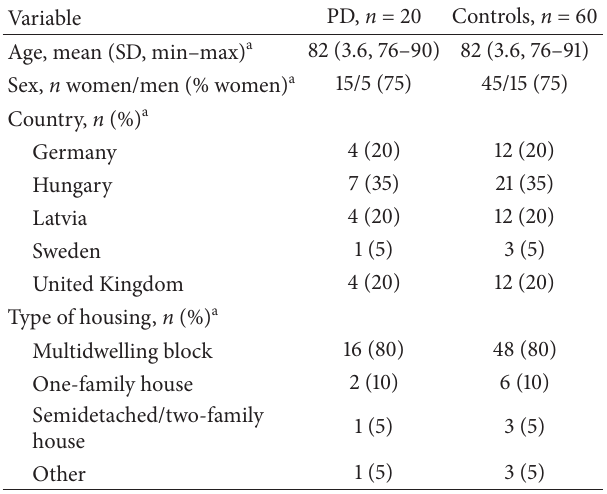
Table 1: Sample characteristics: very old people reporting having Parkinson’s disease (PD) ( n = 20) and controls not reporting having PD ( n =